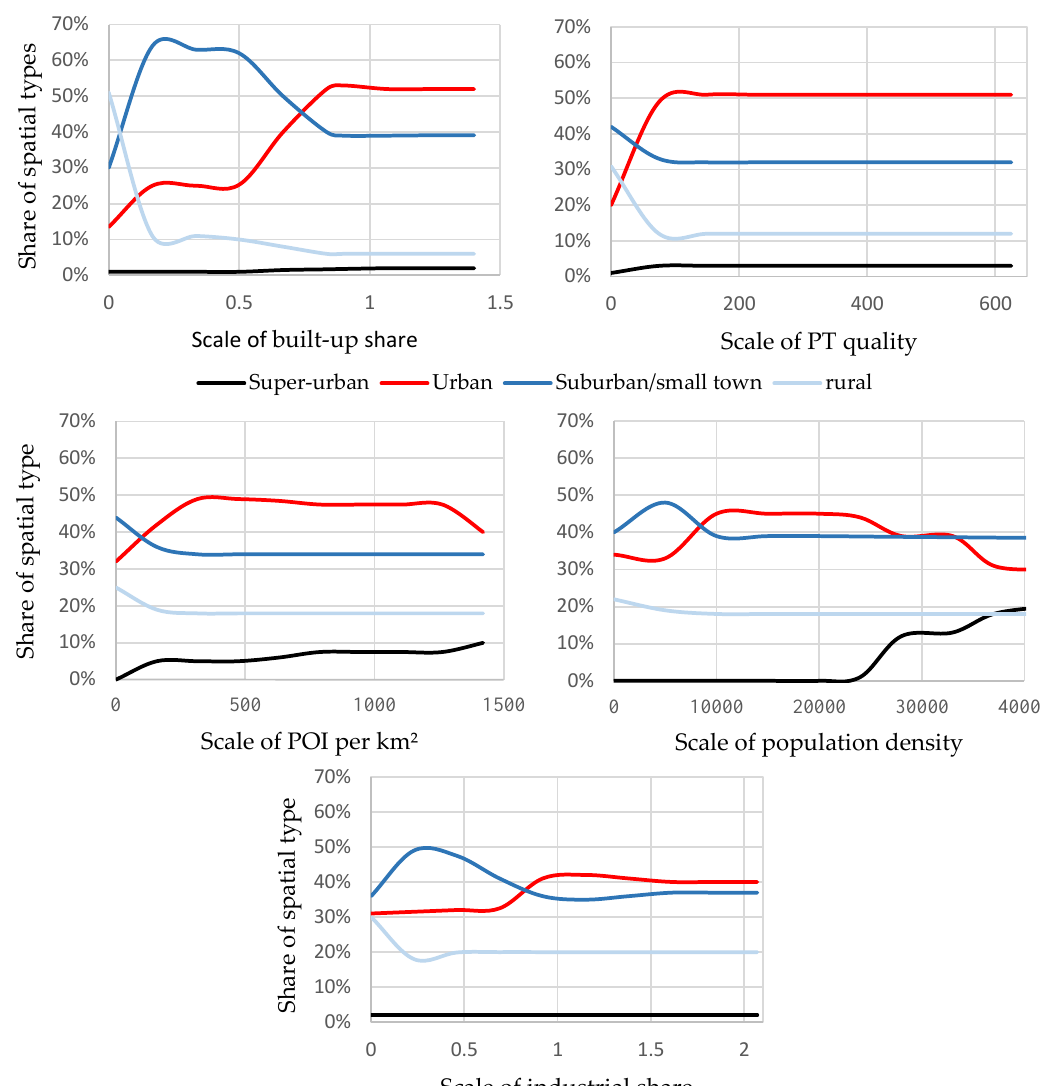
Figure 3. Partial dependence plots of the random forest model.